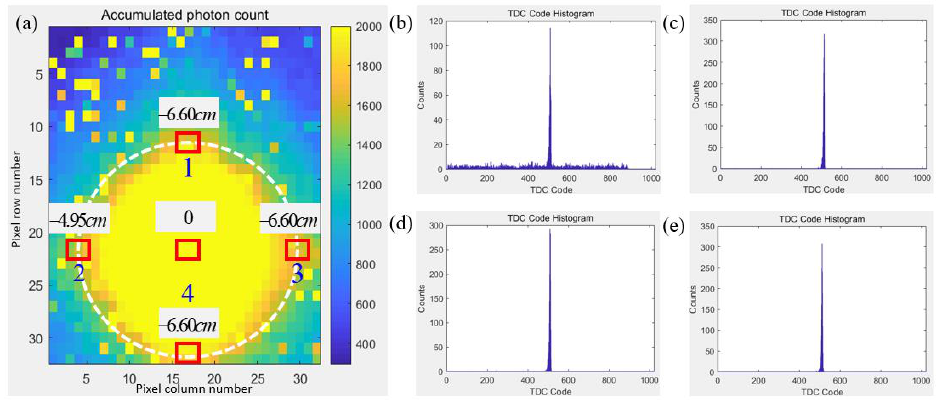
Figure 5. ( a ) Schematic diagram of the deviation of the measured distance at different positions of the light spot. ( b – e ) TCSPC distribution reflecting the distance information of the typical location of the spot